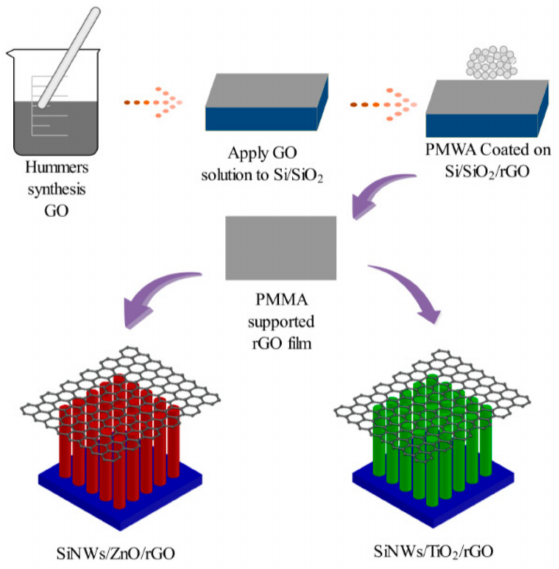
Figure 1. Schematic of the device fabrication